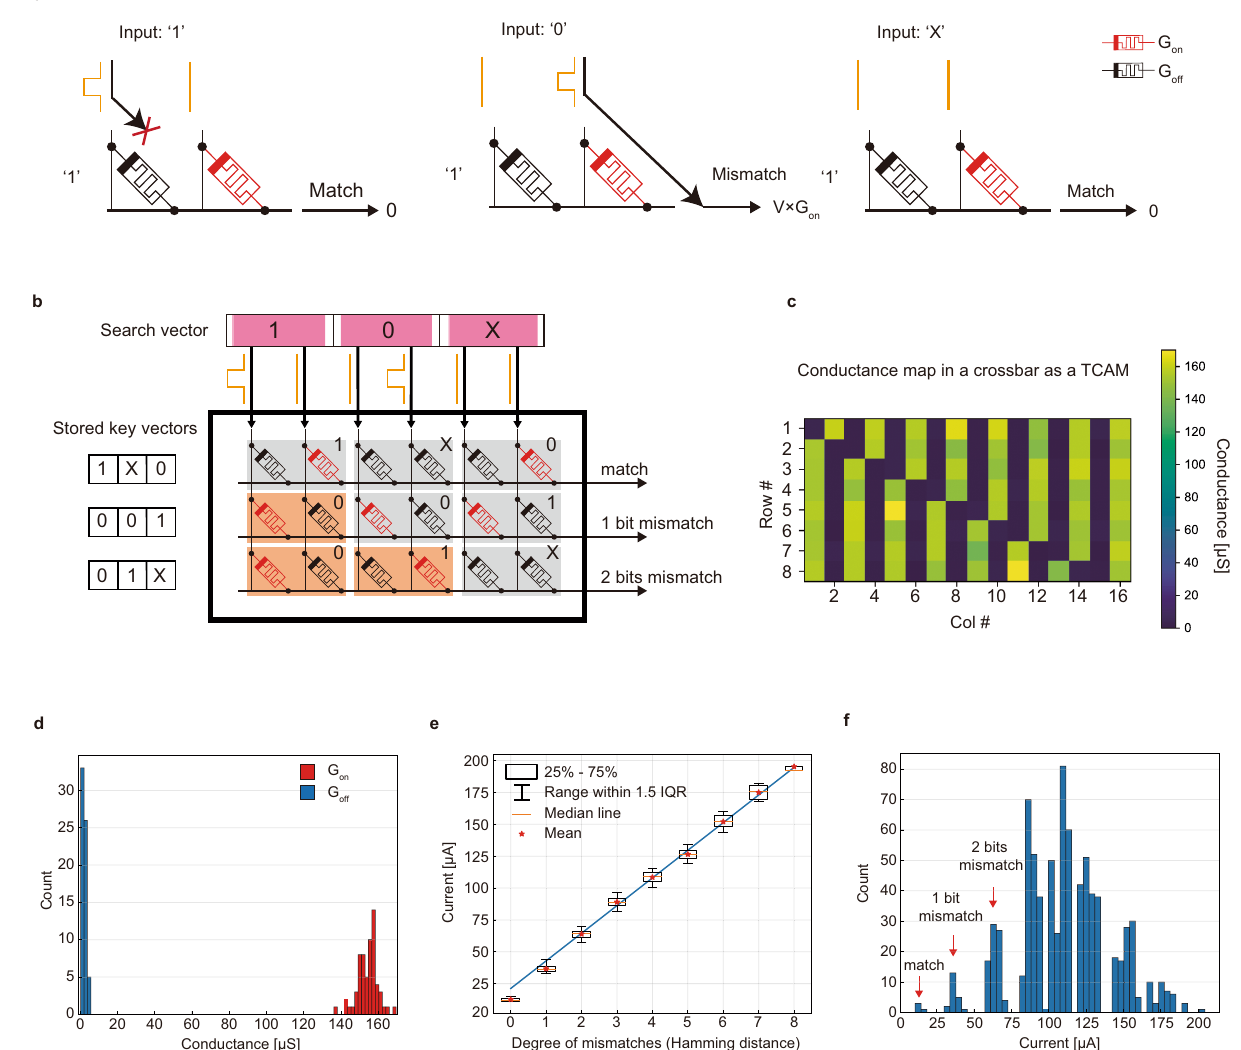
Fig. 3 | TCAM implemented in crossbar array capable of conducting Hamming distance calculation. a Illustration of the basic principle for using dot product to distinguish “ match ” and “ mismatch ” cases. b The schematic of calculating Ham- ming distance in a crossbar. The fi gure shows three 3-dimensional ternary key vectors stored in a 3×6 crossbarwith a differential encoding. Differential voltages representing ternary bits in search vectors are applied to the source line and the output current from the bit line can represent the THD between the search vector